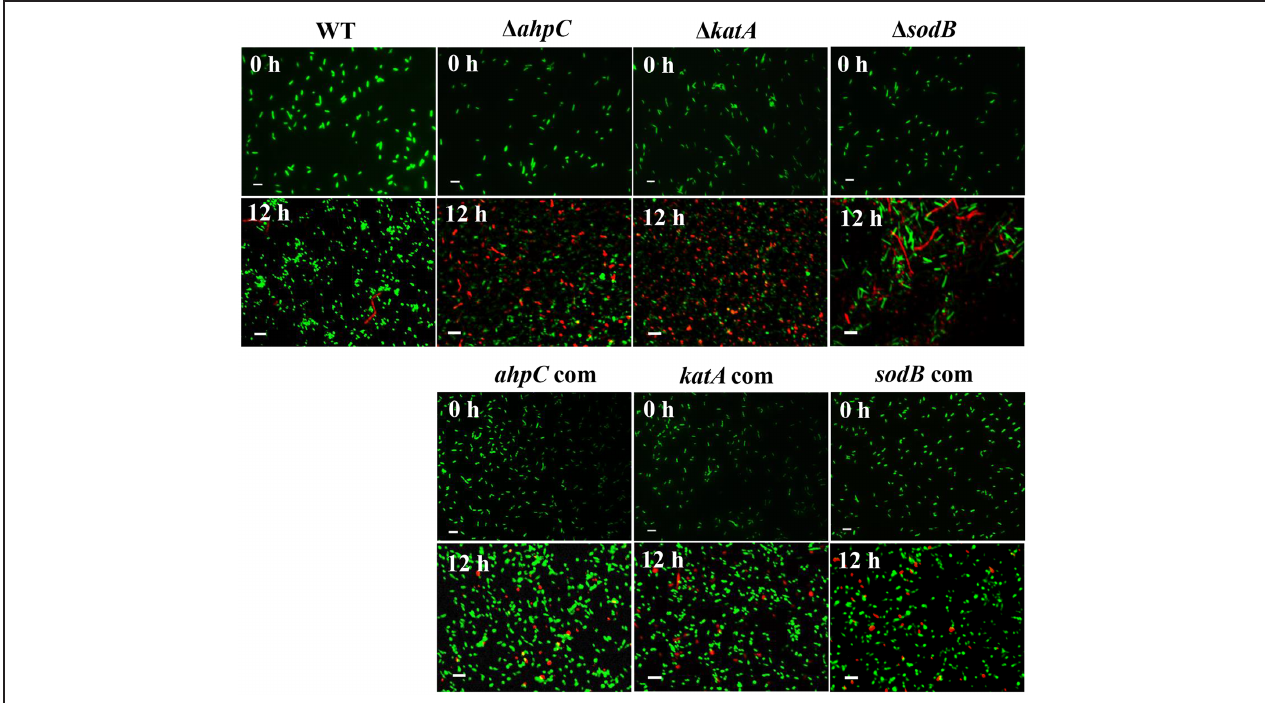
FIGURE 3 | Morphological changes in the oxidative stress defense mutants under aerobic conditions. Samples were stained with the Live/Dead BacLight Bacterial Viability Kit (Life Technologies). Scale bar represents 2 µ m. The images are representative of three independent experiments. The ahpC com, katA com, and sodB com are complementation strains of ahpC , katA , and sodB , respectively.